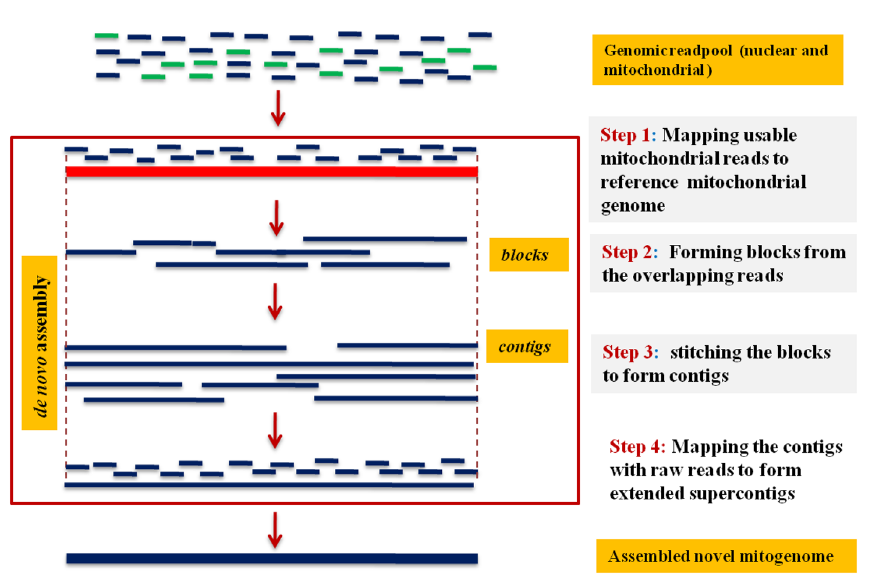
Figure 7. Pipeline adopted for the reference based de-novo assembly of the novel mitogenome from the genomic